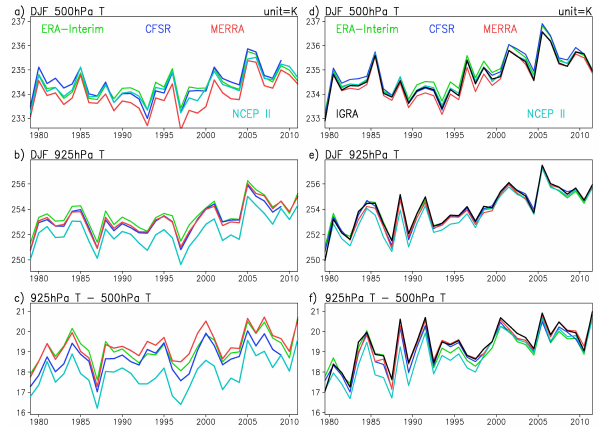
Fig. 3. 70–90 ◦ N average T (temperature) from four reanalyses and the IGRA data. On the left, the true 70–90 ◦ N average is shown. On the right, the average is calculated using only those reanalysis data that match the available IGRA observations in location and time.